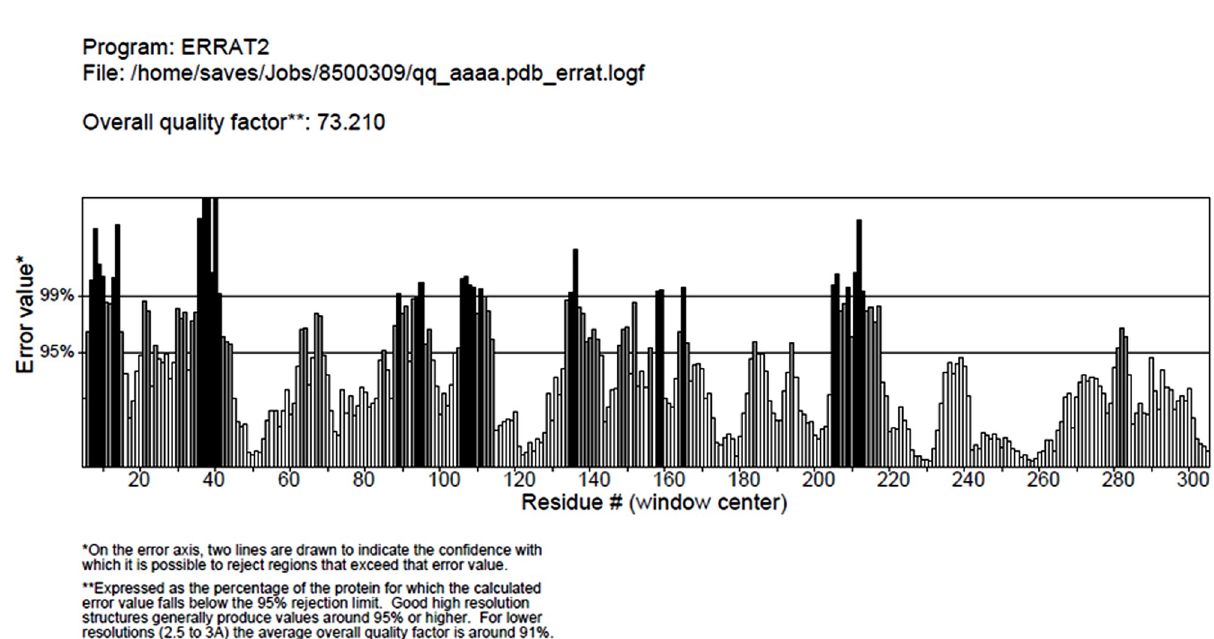
Fig 9. ERRAT measurement of nrtA protein. Values indicate over all structure quality of the traget protein.